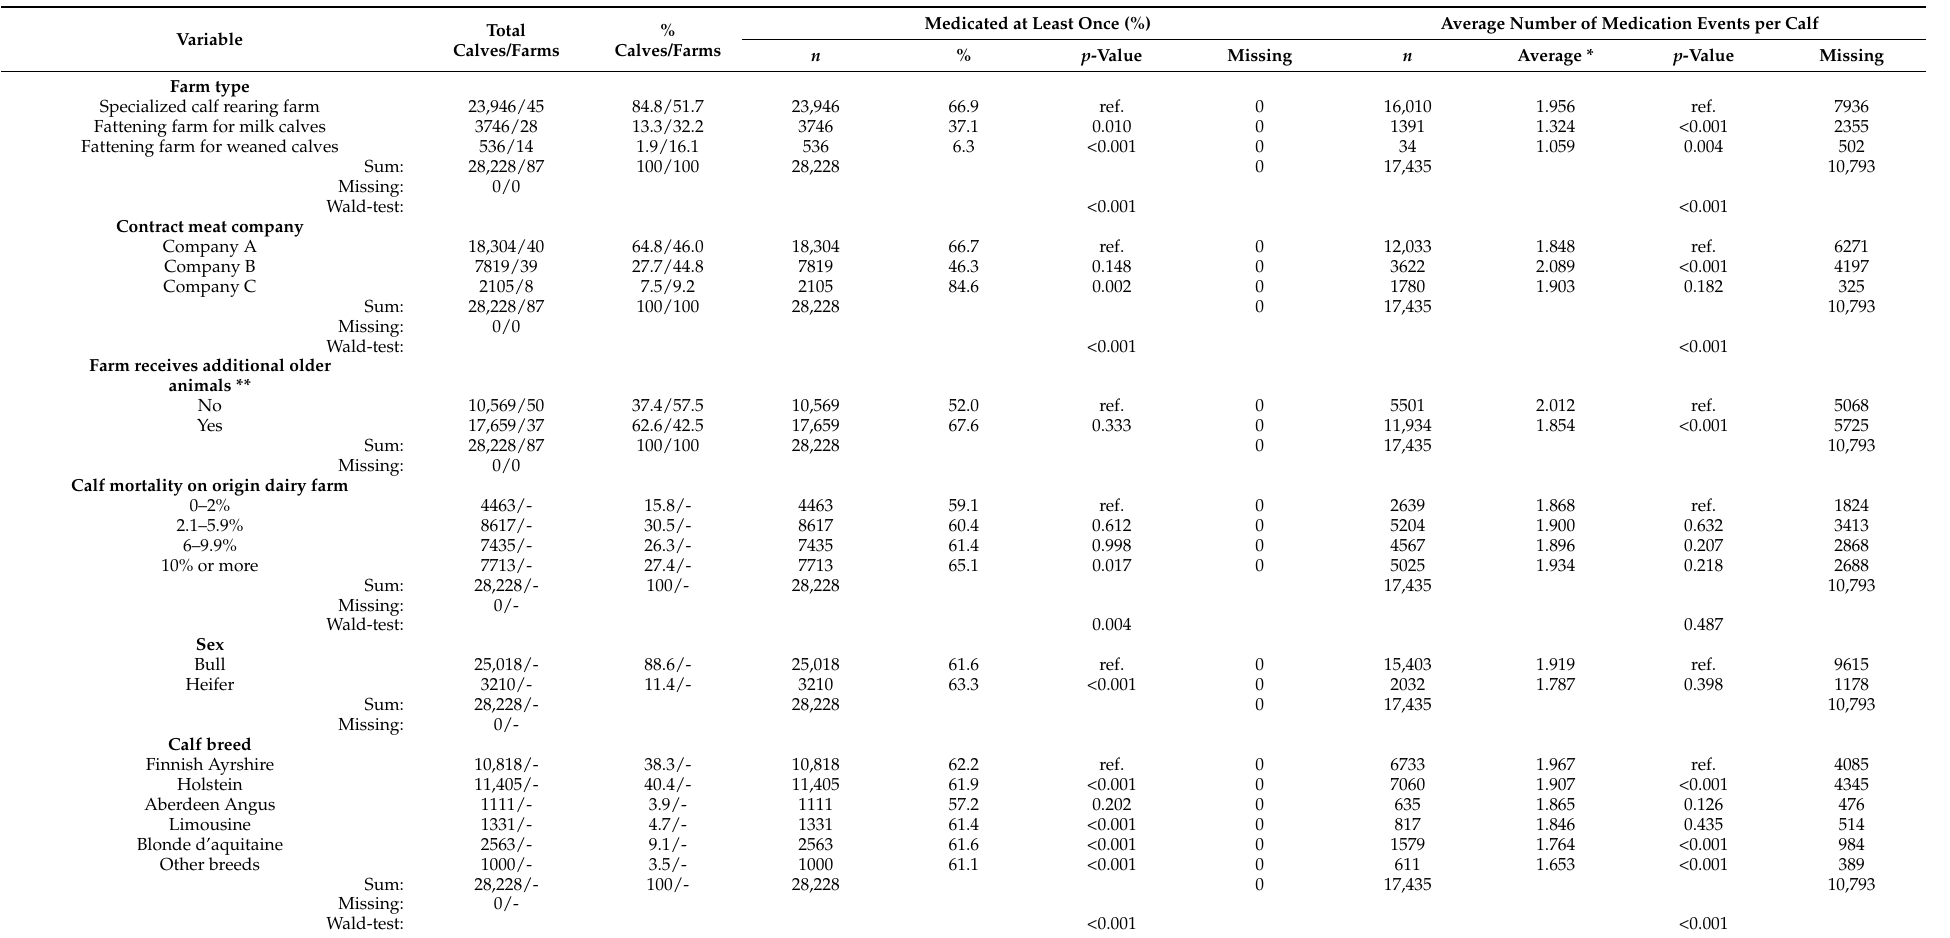
Table 2. Descriptive statistics of calf and farm level data for 28,228 calves reared in 87 calf rearing farms and univariate associations of predictor and outcome